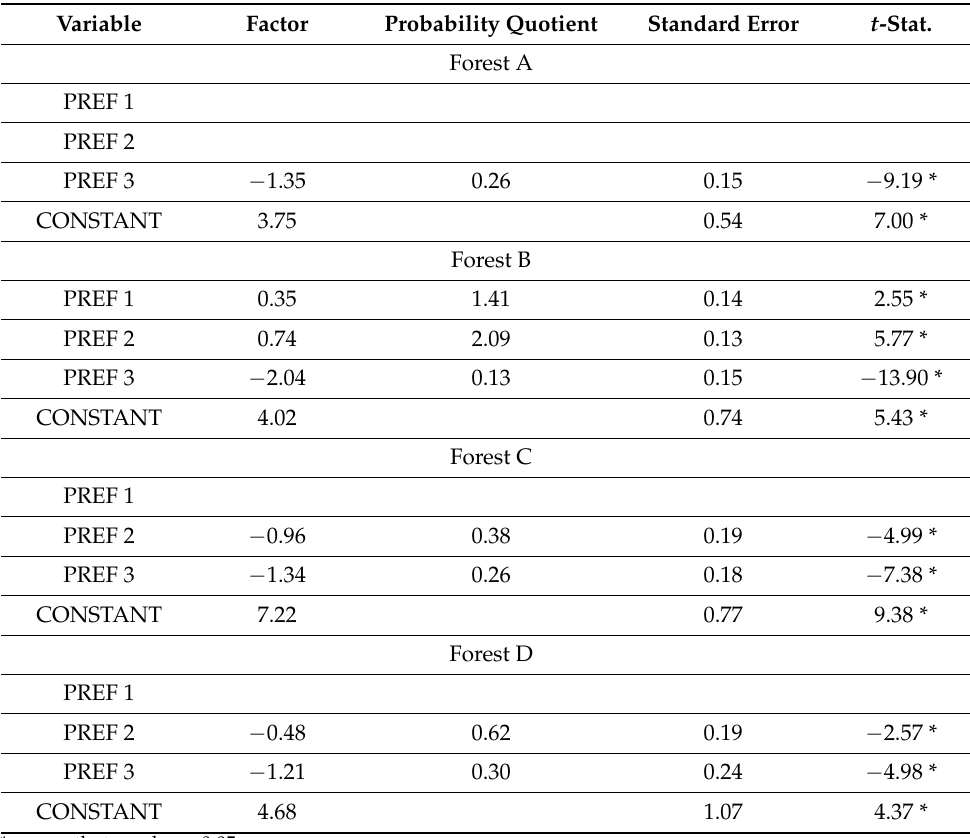
Table 9. Values of estimated variables in the logistic regression model.